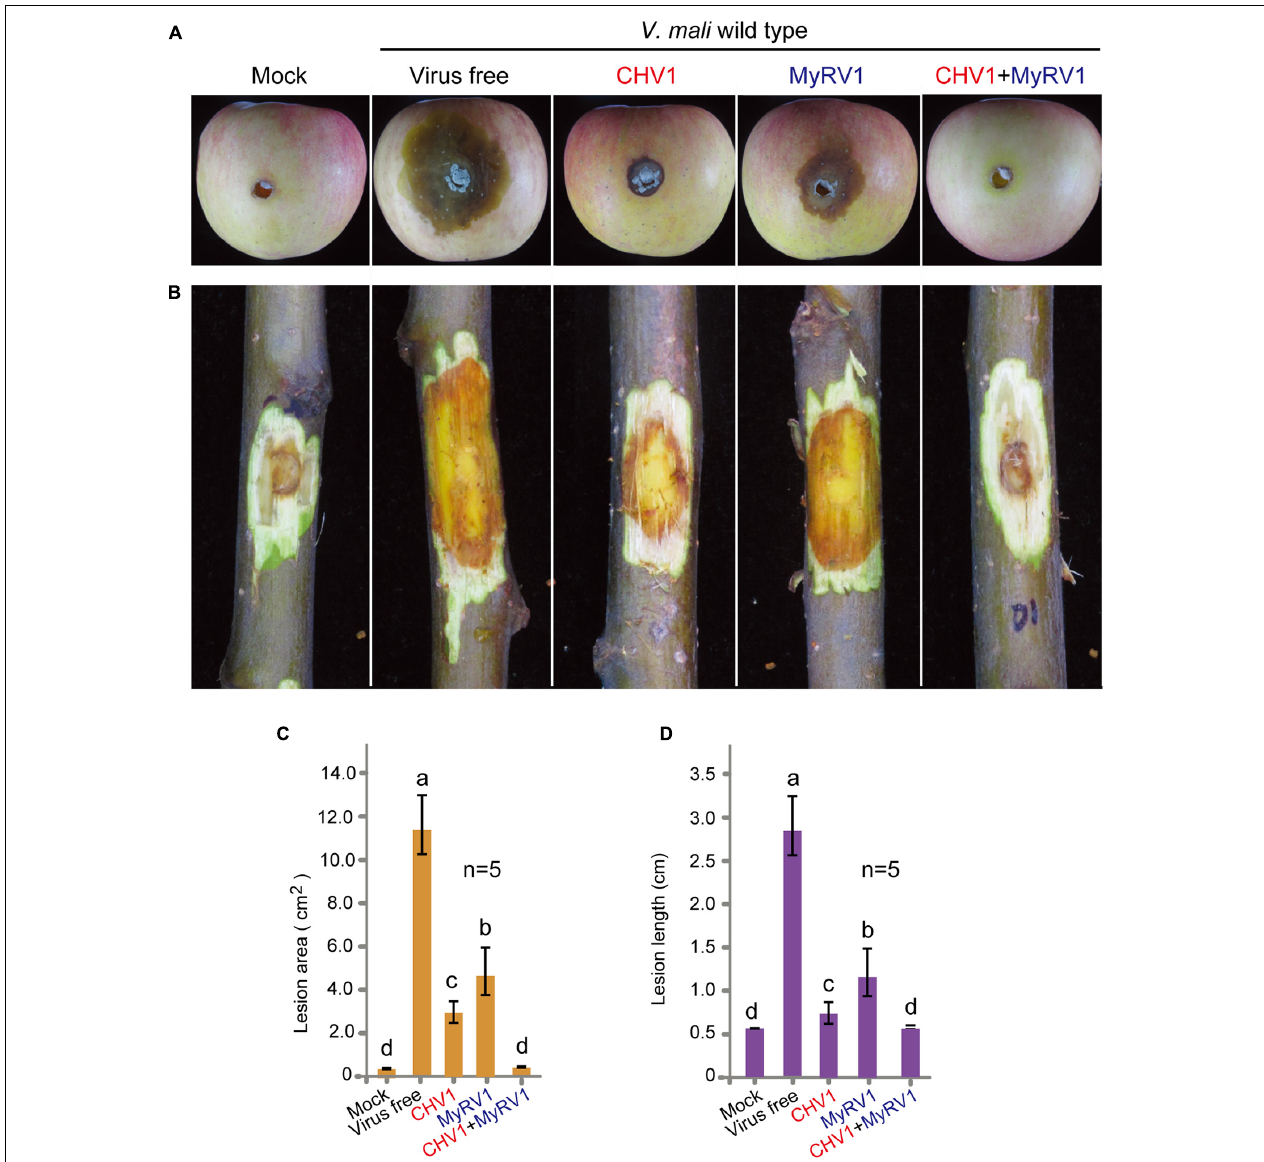
FIGURE 2 | The virulence levels of V. mali strains singly or doubly infected with CHV1 and MyRV1. (A) Representative images showing lesions on apples induced by V. mali strains. The cankers were photographed at 5 days post-inoculation. (B) Representative images showing lesions on apple twigs induced by V. mali strains. The lesions on twigs were photographed at 5 days post-inoculation. (C) Lesion areas on apples measured in the experiment described in (A) . The data are the means ± SD ( n = 5). The different letters indicate a significant difference at p < 0.01 (one-way ANOVA). (D) Lesion lengths on apple twigs measured in the experiment described in (B) . The data are the means ± SD ( n = 5). The different letters indicate a significant difference at p < 0.01 (one-way